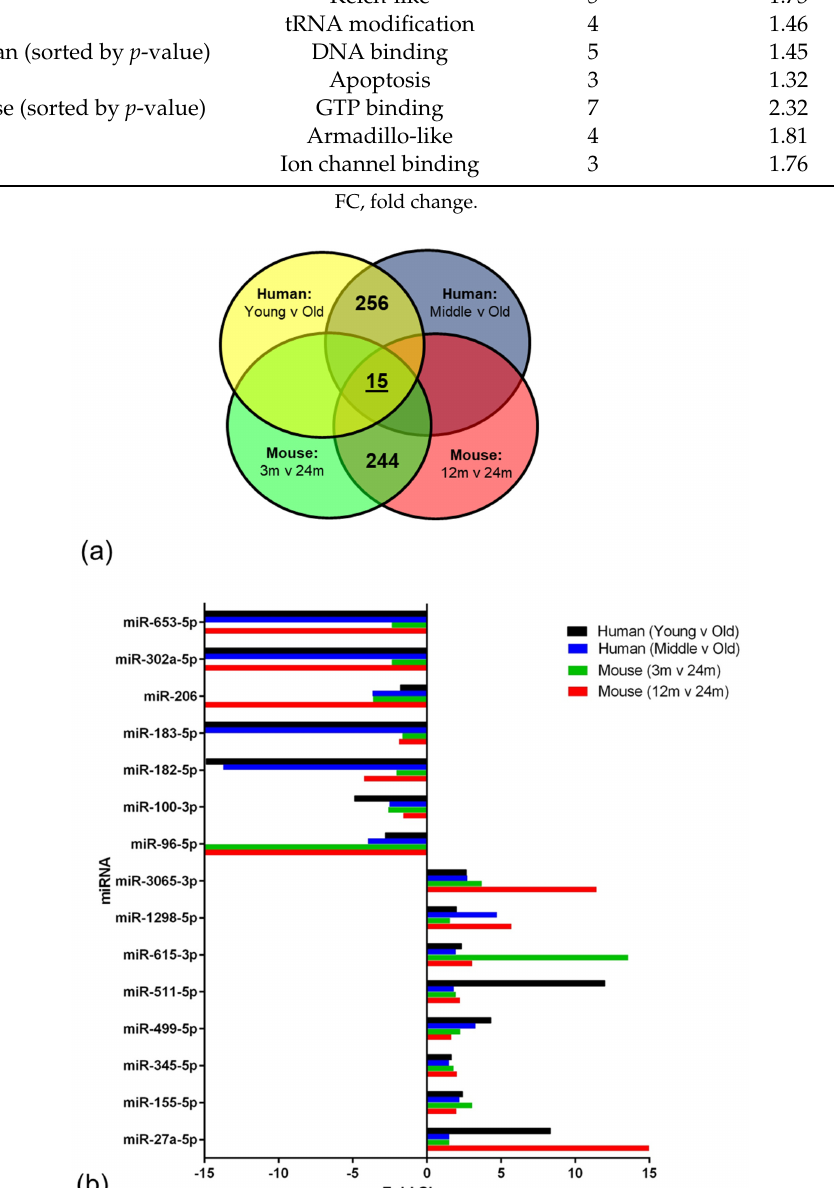
Figure 3. miRNA expression analysis. ( a ) miRNA expression in the human and mouse age group comparisons. Numbers of overlapping miRNAs within species and between all four comparisons are indicated in appropriate sections. ( b ) fold change profiles for the panel of 15 overlapping miRNAs between species. The Targetscan software was used to specifically identify miRNAs with target genes relating to DNA binding and autophagy (identified in the human mRNA analysis). The miRNAs targeting genes related to autophagy were miR-181c-3p and 505-5p which target TP53 and miR-505-5p which targets arylsulfatase A ( ARSA ), while those targeting genes related to DNA binding are shown in Table 2.